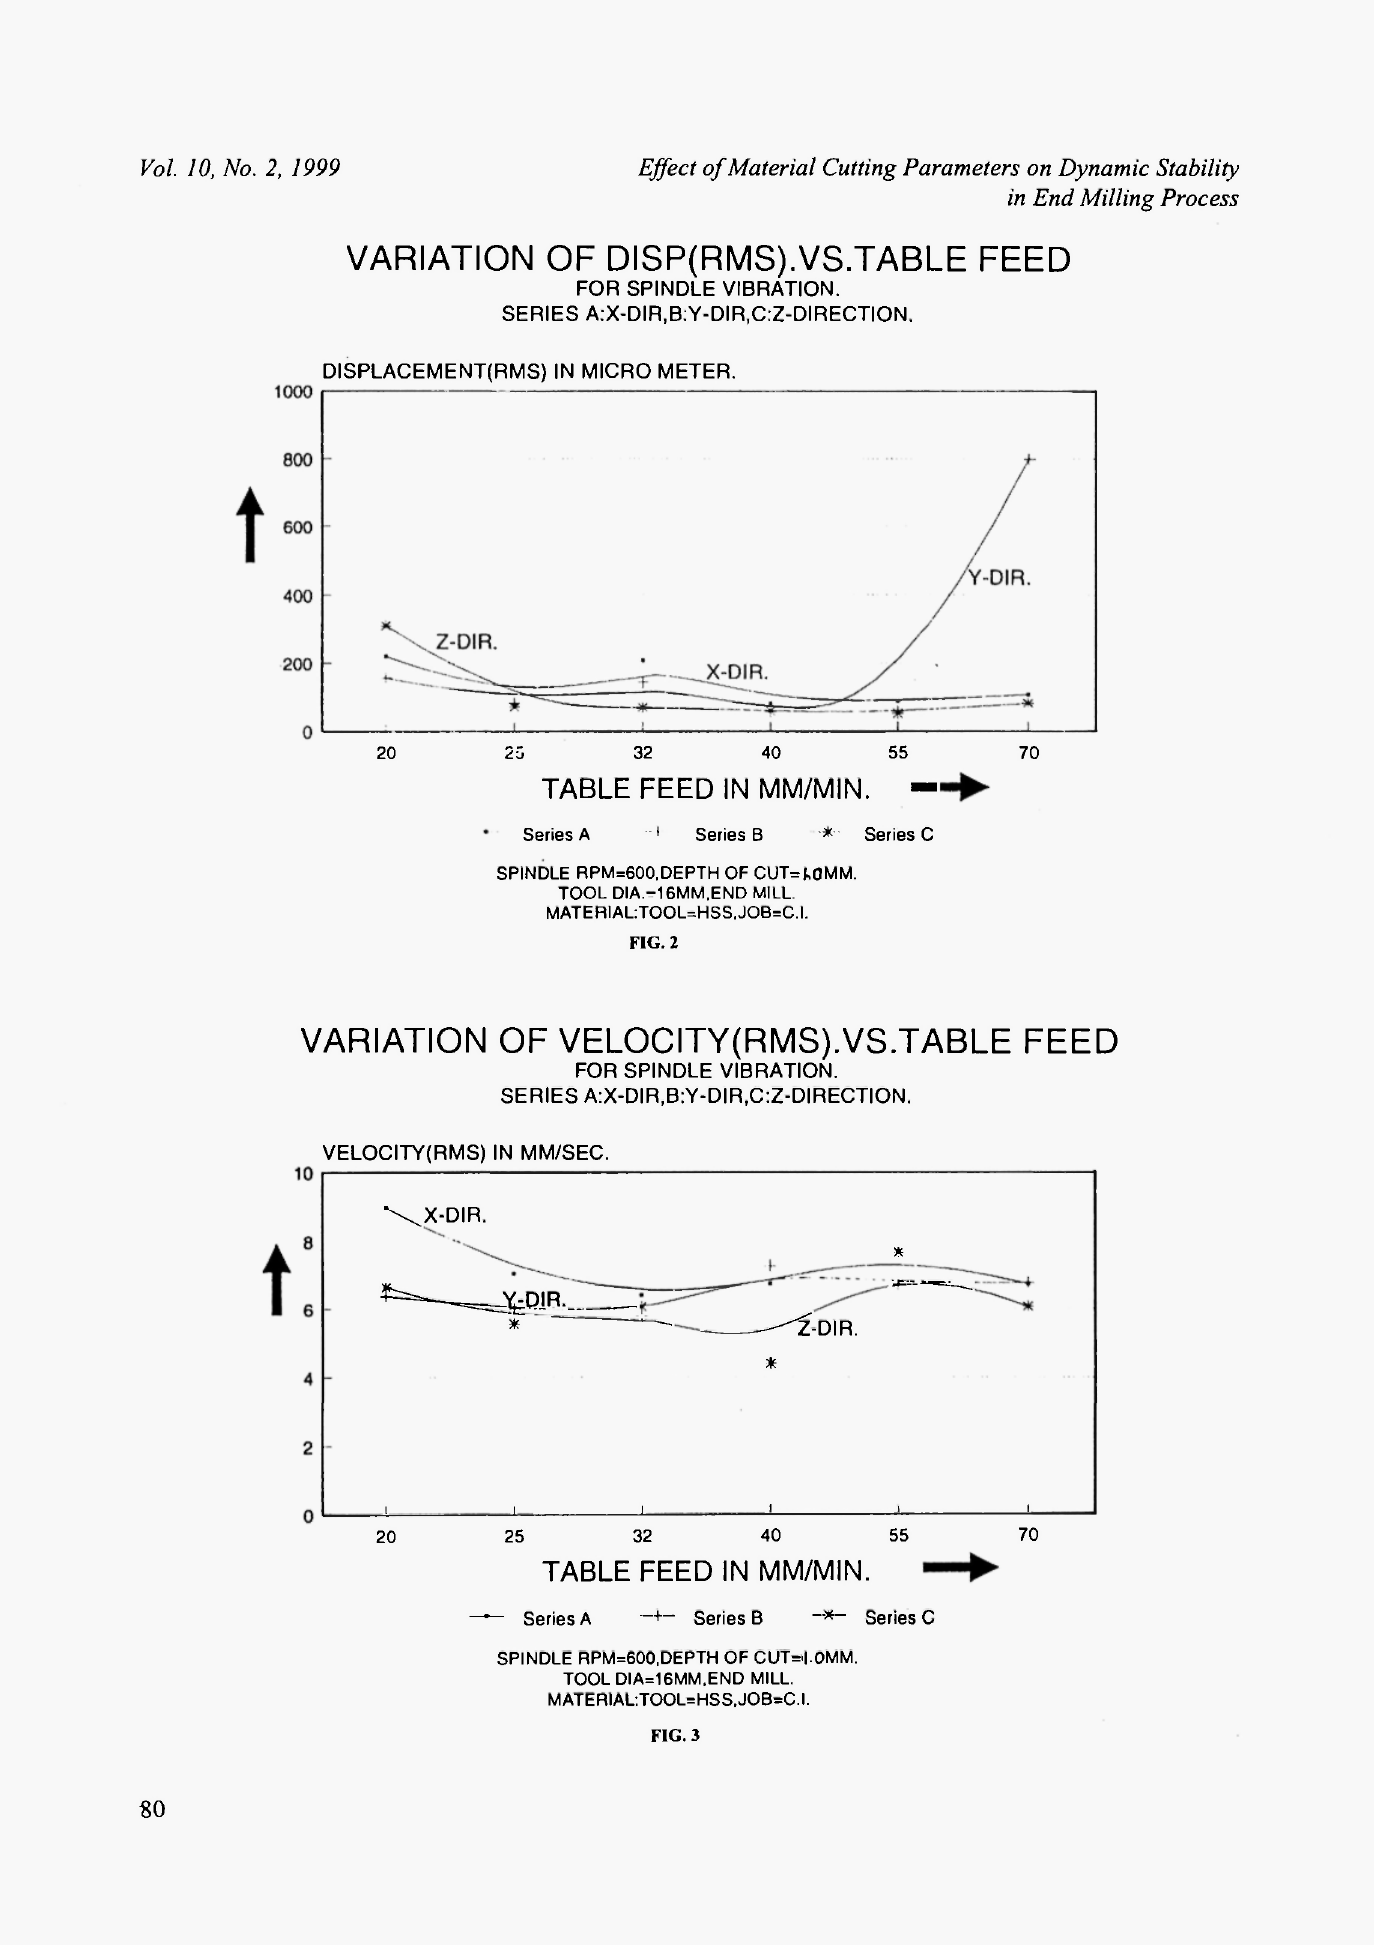
VARIATION OF VELOCITY(RMS).VS.TABLE FEED FOR SPINDLE VIBRATION.